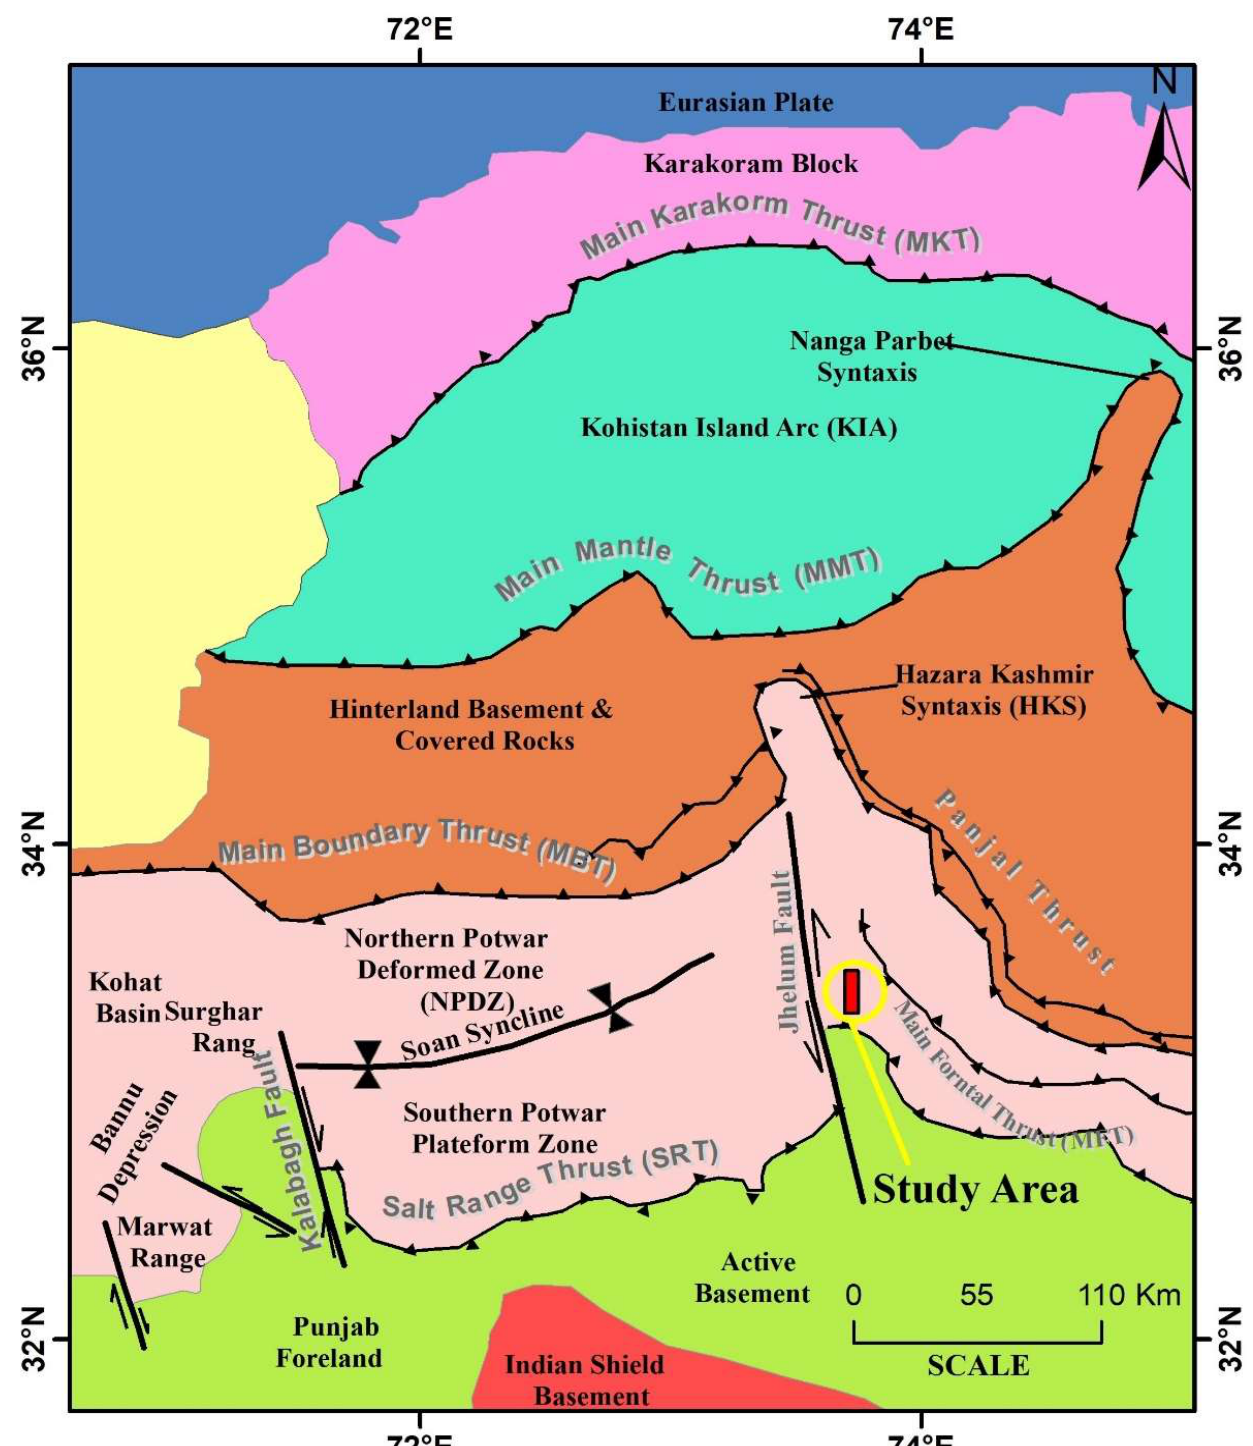
Figure 1. A northern Pakistan tectonic map showing study area (Modified and compared after Basharat, et al. [8], Avouac , et al. [9], Greco [10], Baig and Lawrence [11], Calkins , et al. [12] and Wadia [13]).